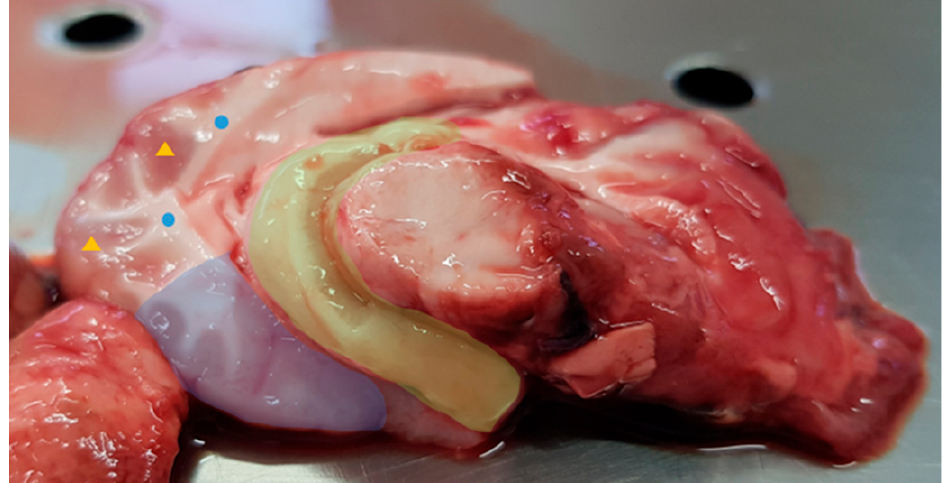
Figure 1. Lamb right brain hemisphere. The four collected parts are highlighted in the figure: prefrontal cortex and hippocampus are filled in blue and yellow, respectively; grey matter is identified with the yellow triangles and white matter with the blue circles.